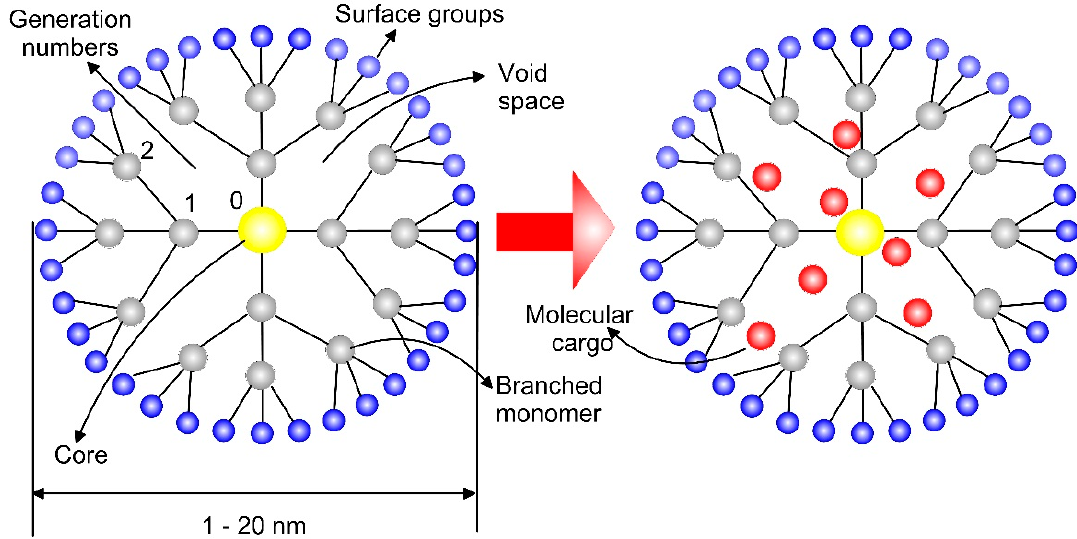
Figure 4. General representation of a model structure of a dendrimer and possible dendrimer-molecular cargo interactions.